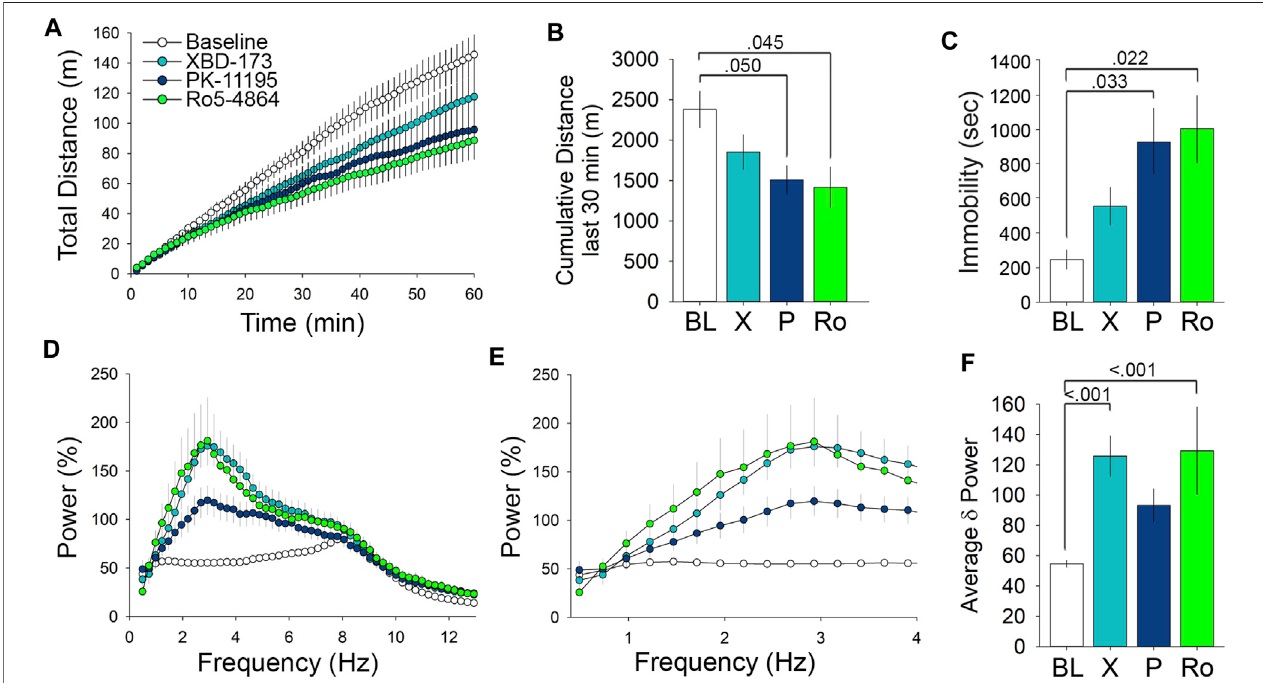
FIGURE 5 | Comparison of the behavioral and EEG effects of TSPO modulators at 1 mg/kg reveals effects on locomotor activity and low frequency δ wavelength power. (A) Comparison of the effect of 1 mg/kg doses of the tested TSPO modulators on distance travelled in the open fi eld. (B) Measure of the cumulative distance travelled during the last 30 min of the open fi eld comparing the 1 mg/kg doses. (C) Immobility in the open fi eld following 1 mg/kg doses. (D) cFFT comparing the EEG effects of 1 mg/kg doses of the tested TSPO modulators, showing the prominent effects of XBD-173 and Ro5-4864 on low frequency wavelengths compared to baselinelevels. (E) cFFTofwavelengthsinthe δ frequencyrangecomparingthetestedTSPOmodulatorsat1 mg/kg. (F) Average δ powershowingtheelevationcaused by 1 mg/kg XBD-173 and Ro5-4864 compared to